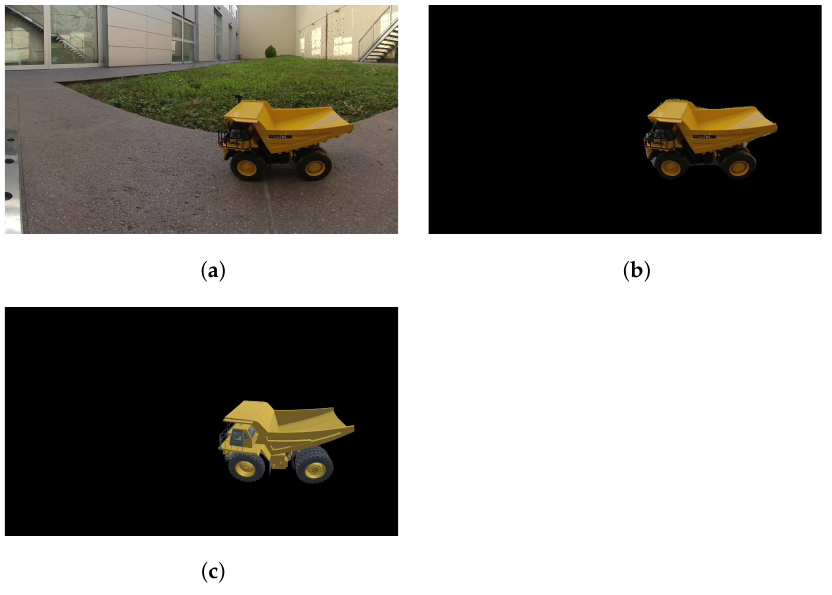
Figure 13. Optimization result where the camera was rotated by 45°. ( a ) Input equirectangular image taken by the 360° camera. ( b ) Result of the segmentation. ( c ) Optimization result in which the CAD is rendered in the final pose found by the optimization